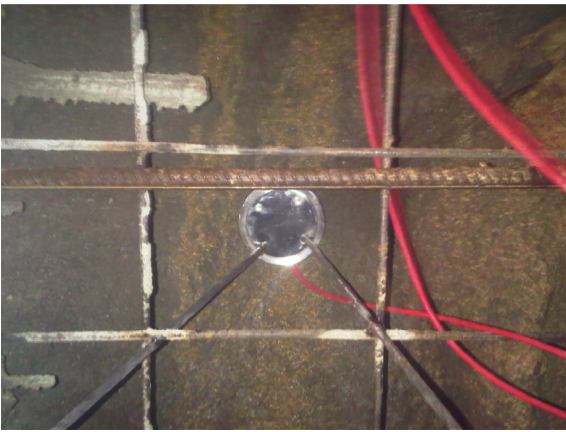
Figure 4: Measuring points of surrounding rock pressure.